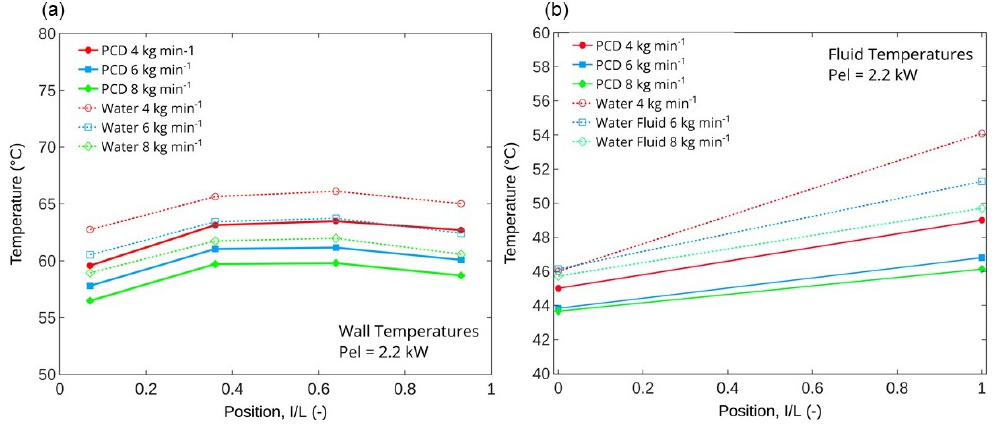
Figure 4. Comparing the temperatures of the PCD and water for an electrical heating input of 2.2 kW and at three different mass flow rates (4, 6 and 8 kg min − 1 ) as a function of the dimensionless position for ( a ) the wall temperatures and ( b ) the bulk fluid inlet and outlet temperatures.